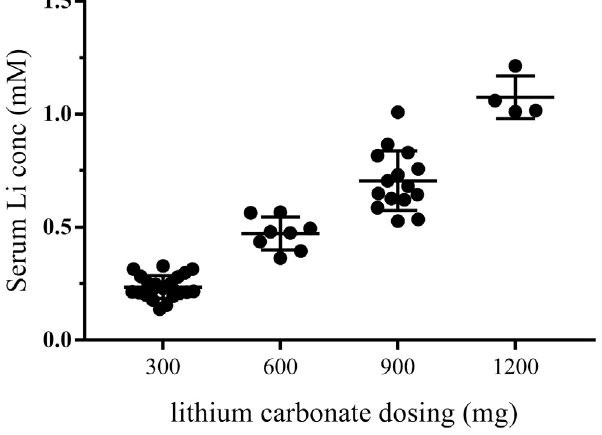
FIGURE 2 | Plasma lithium levels after receiving lithium carbonate. Every point represents that plasma lithium levels were detected after receiving lithiumat dosesof300,600,900,or1,200 mg.The fi rstmonthwas the dose adjustment period. and plasma lithium levels were measured by IC-MS once a week. The plasma lithium levels were then examined approximately every 3 months after the fi rst month. Therefore, the lithium plasma levels of one patient were detected several times at one dose. conc,